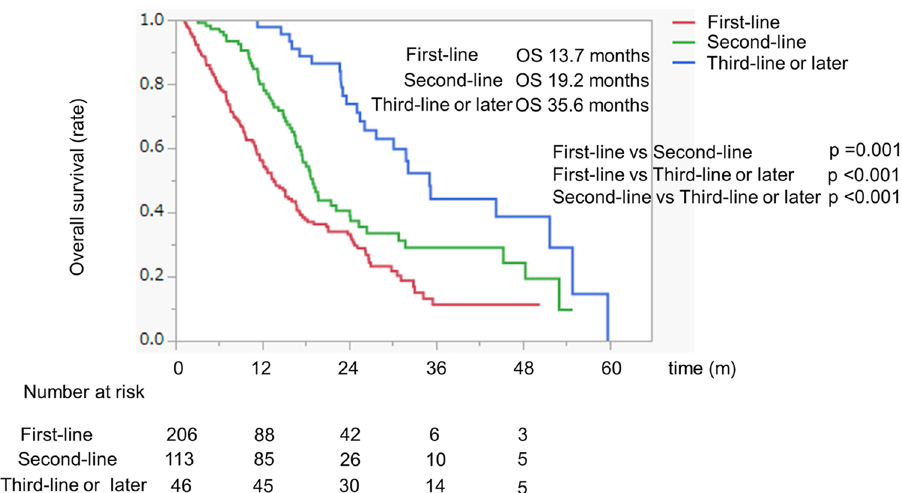
Figure 2. The overall survival of patients with HCC treated with systemic therapy. The red, green, and blue lines indicate the first-line, second-line, and third-line or later-line therapy groups, respectively. Abbreviations: HCC, hepatocellular carcinoma.